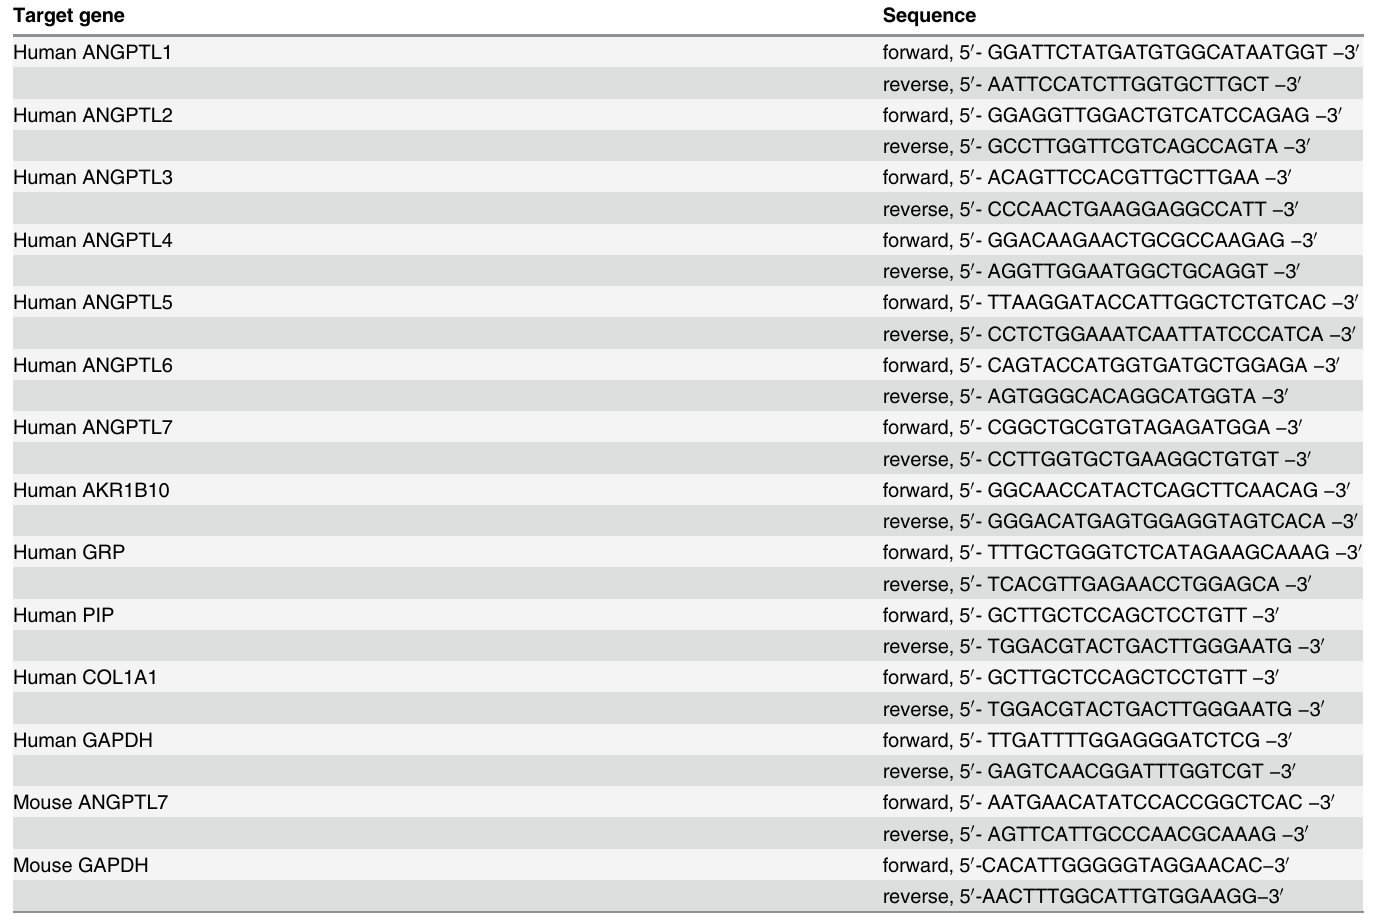
Table 1. Primer sets for qPCR